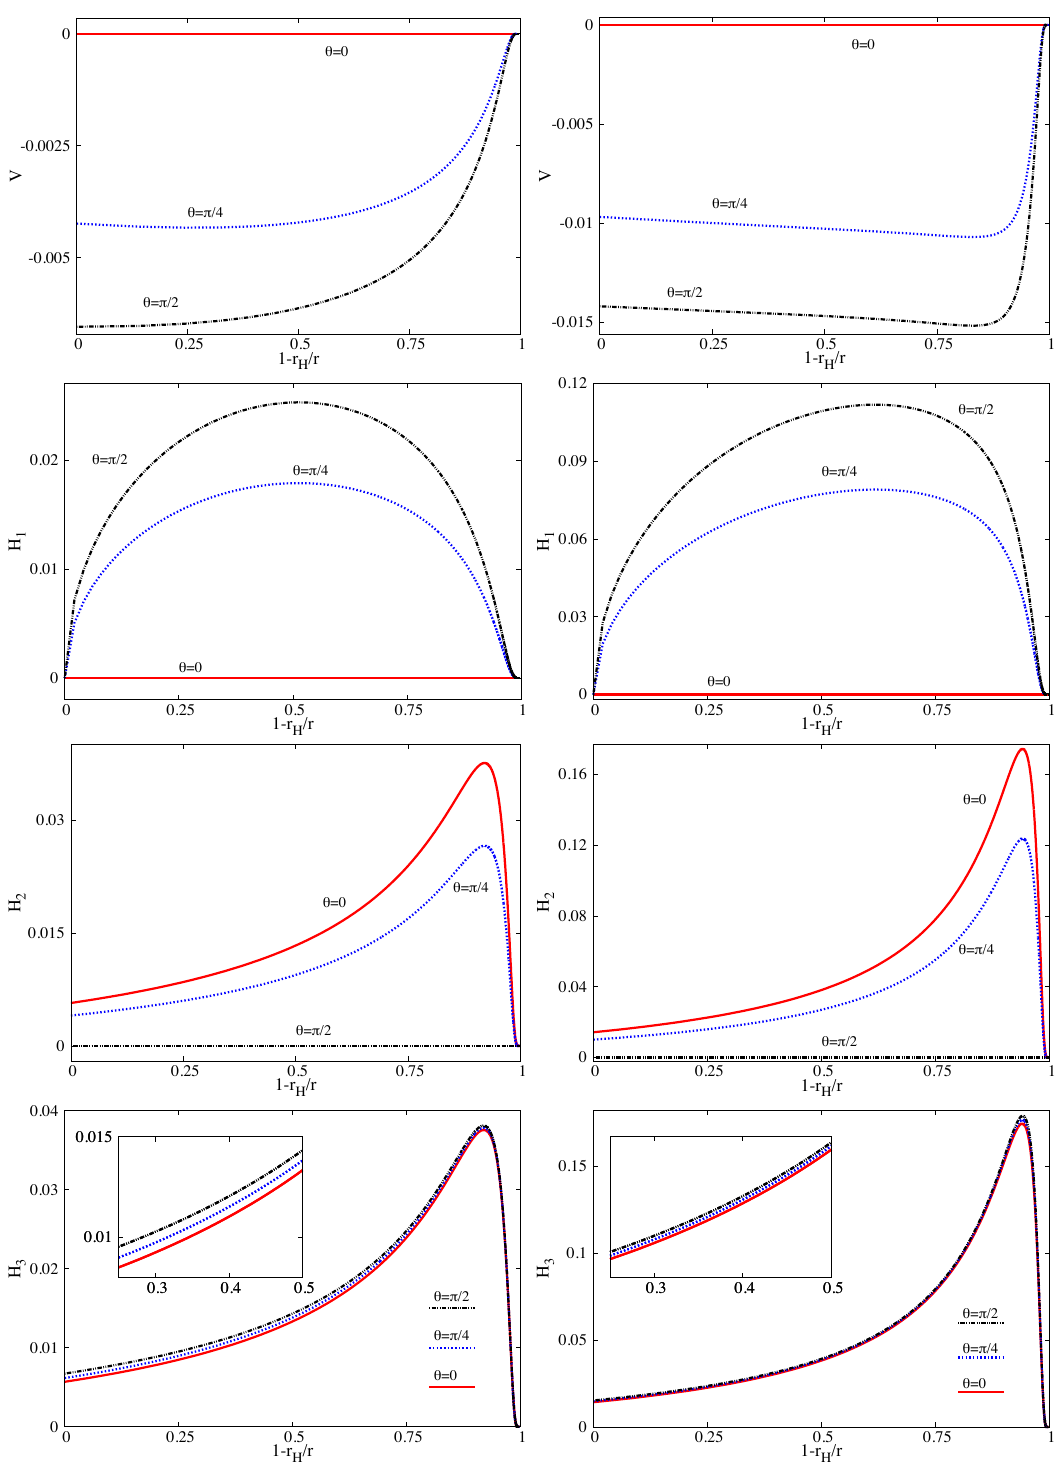
Figure 10 . Proca potential functions of HBH 1 (left panel) and HBH 2 (right panel).